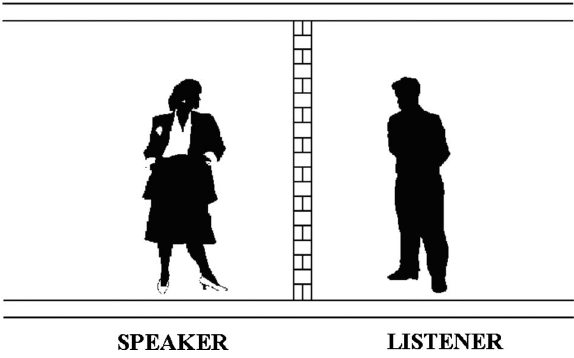
FIG. 7. Picture available to students for better understanding of the situation and for optional drawing during discussion related to context 4 in interview protocol.